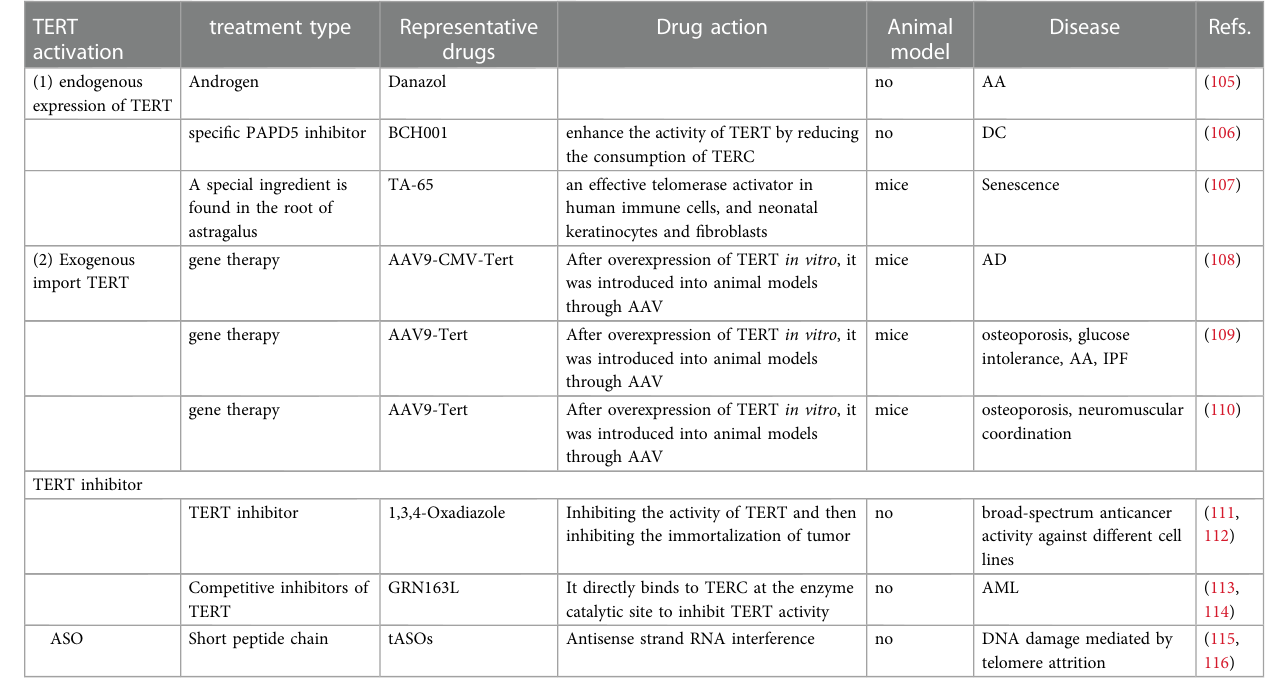
( Table 2 and Figure 3 ). Research on the treatment of telomere dysfunction-associated pediatric diseases is lacking. Therefore, both the change in telomerase activity and maintenance of TL may be potential targets for pediatric diseases.